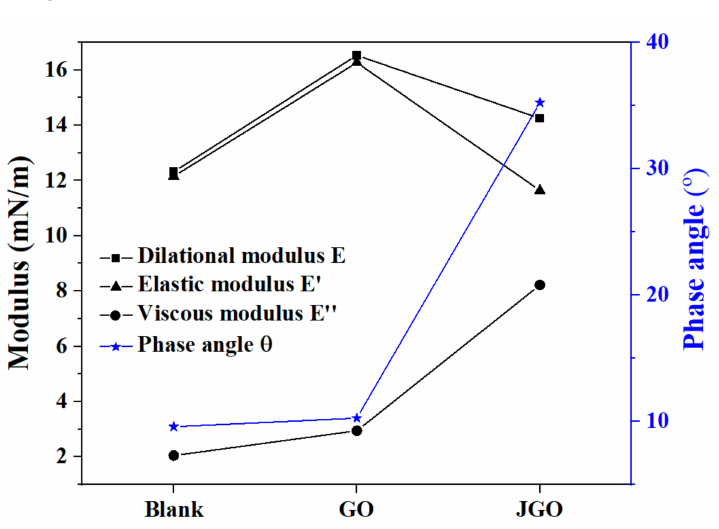
Figure 5. Effects of GO and JGO on the interfacial rheology of crude oil/water